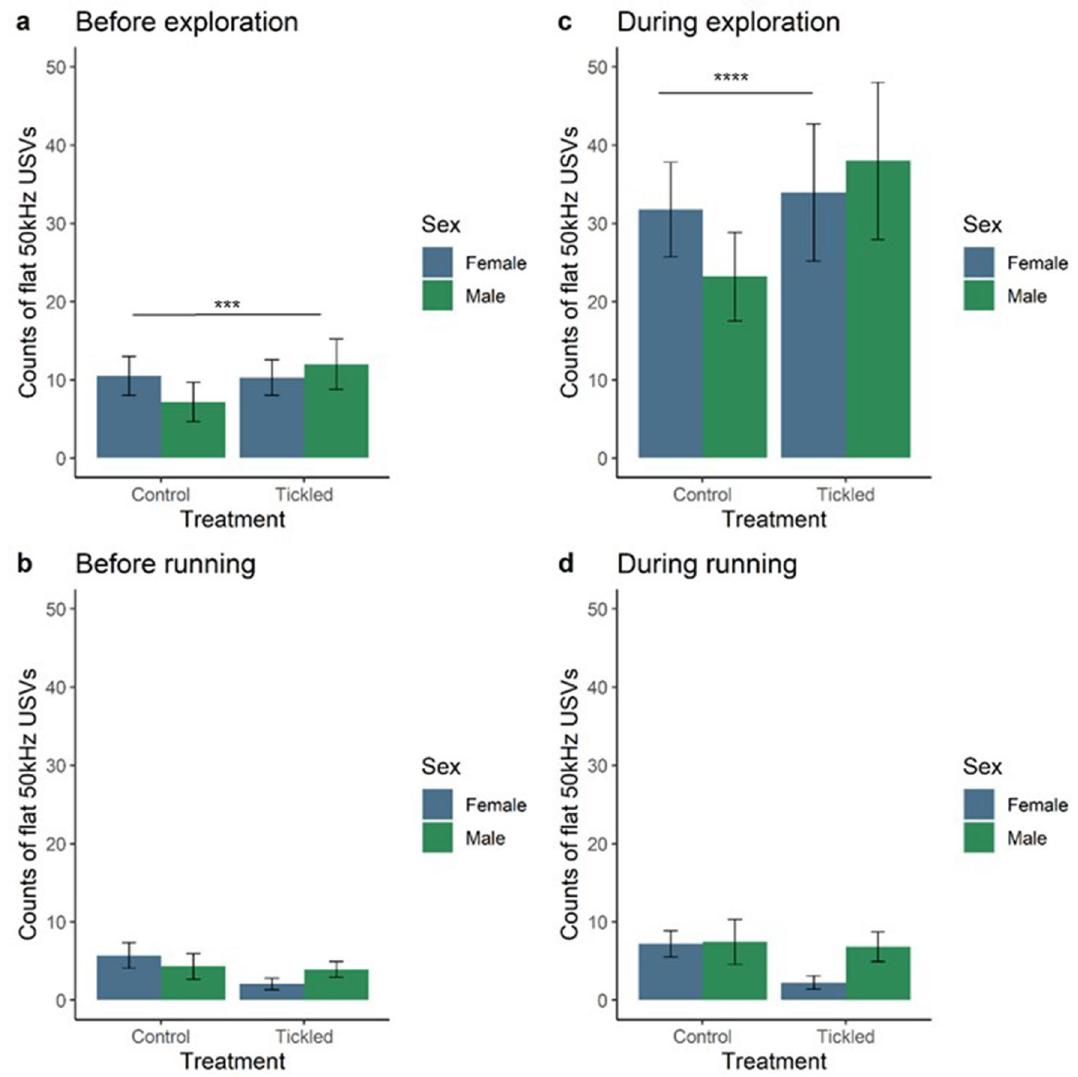
Figure 3. Flat ultrasonic vocalisations (USVs) paired with explorations, but not running, in tickled compared to control rats. Estimated marginal means ±95% CI of flat 50 kHz USVs produced in the one second before exploration ( a ) and running ( b ), and flat 50 kHz USVs produced during exploration ( c ) and running ( d ) ‘non play-related’ behaviours. Female rats (blue) and male rats (green). n = 16/group. *denotes p ≤ 0.05; **denotes p ≤ 0.01; *** denotes p ≤ 0.001; **** denotes p ≤ 0.0001 for significant pairwise USV production associated with non‑play‑related behaviours. Exploring. The interaction between treatment and sex had an overall effect on the number of flat USVs emitted in the one second before (X 2 (1,63) = 10.86, p = 0.0010) and during (X 2 (1,63) = 22.41, p < 0.0001) exploring (Fig. 3). Pairwise comparisons revealed differences between control and tickled males, with control males emitting a lower mean number of flat 50 kHz USVs emitted before (t ratio = − 4.35, p = 0.0003) and during (t ratio = − 7.50, p < 0.0001) exploring than tickled males. In contrast to play-related behaviours, there was a treatment, but not a sex, effect on flat USVs being paired with exploration (Fig. 3). Irrespective of sex, tickled rats made more flat USVs before (X 2 (1,63) = 8.062, p = 0.0045) and during exploration compared to control rats (X 2 (1,63) = 34.98, p < 0.0001). The interaction between treatment and sex had an overall effect on the number of FM USVs emitted in the one second before (X 2 (1,63) = 29.99, p < 0.0001) and during (X 2 (1,63) = 116.11, p < 0.0001) exploration (Fig. 4). Control females made more FM USVs before exploration than tickled females (t ratio = 2.74, p = 0.0400), while tickled males had higher rates of FM USVs before exploration than control males (t ratio = − 5.10, p < 0.0001). This was also observed during exploratory behaviour with control females making more FM 50 kHz USVs during exploration than tickled females (t ratio = 7.15, p < 0.0001), and tickled males made more FMs than control males (t ratio = − 8.14, p < 0.0001). Within the tickled groups, males emitted a higher mean number of FM 50 kHz USVs during exploration compared to females (t ratio = − 4.09, p = 0.0008). In contrast to play-related behaviours, tickling did not affect FM USVs when paired with exploration. There was no main effect of treatment (before: